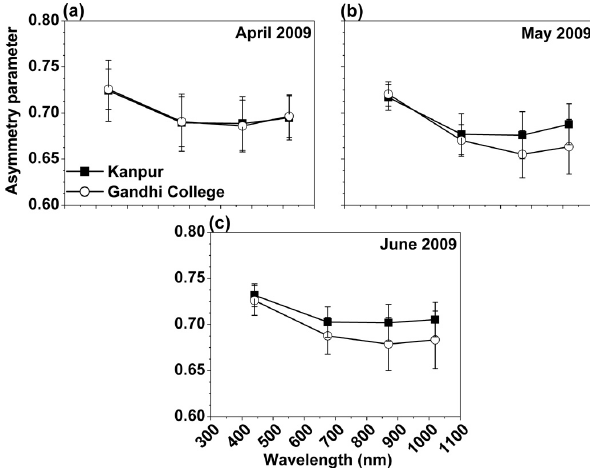
Fig. 8. Same as Fig. 6 for AP at four discrete wavelengths (440, 675, 880 and